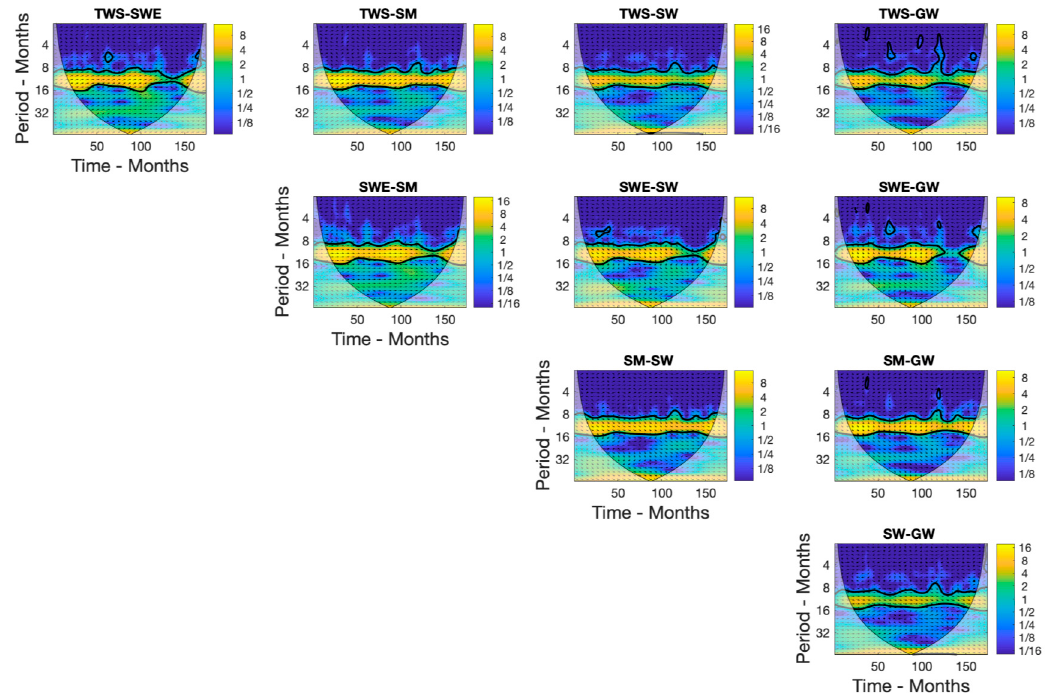
Figure 6. Wavelet analysis showing the frequency at which there is a clear signature that the two plotted processes are correlated. For example, the panel on the top right shows that, for TWS and groundwater, there is a high power signal (yellow colors), which indicates there is high correlation at around 8-16 months. Outside of this time window, there is a low power signal (blue colors) which indicates there is little correlation between the two processes.